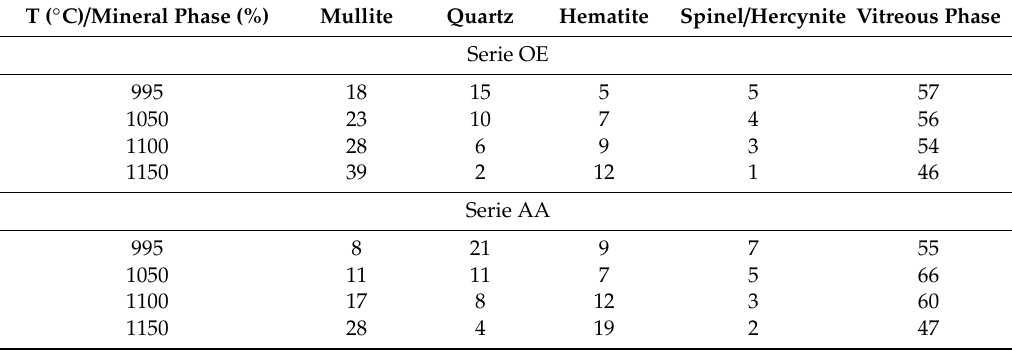
Table 4. Mineral quantification of fired tile bodies